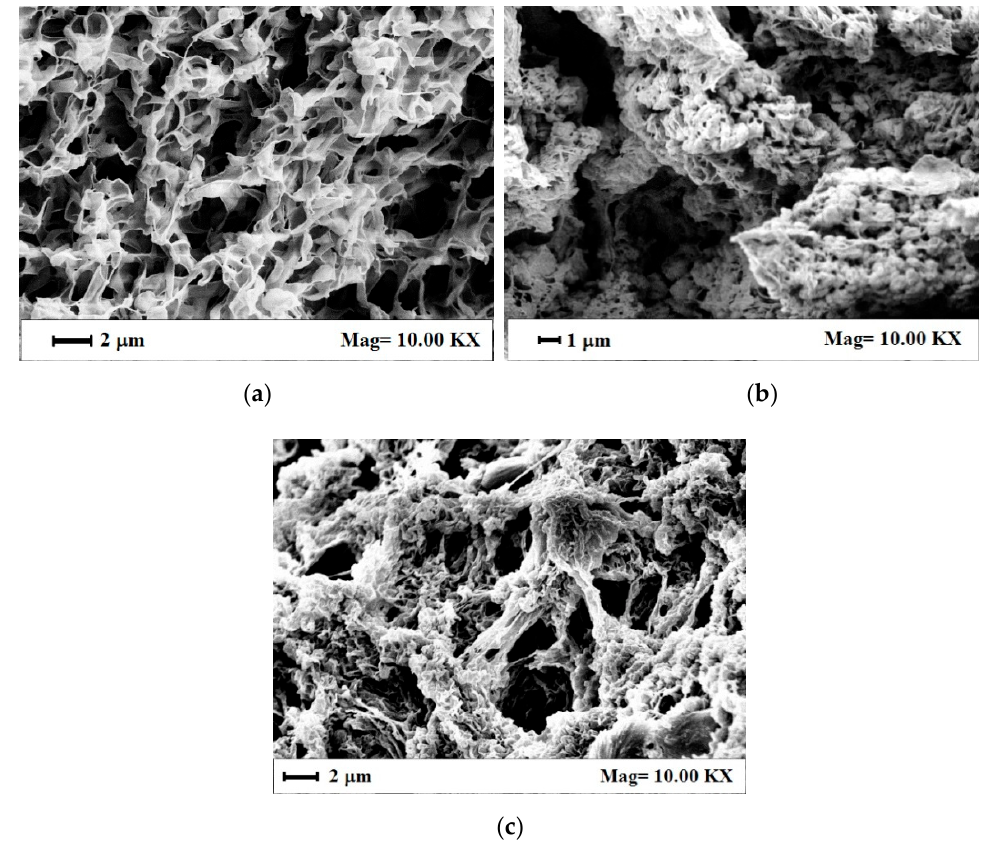
Figure 6. SEM images of the internal aerogel section: ( a ) PVDF HFP alone, ( b ) PVDF HFP_RuO 2 10, ( c ) PVDF HFP_RuO 2 60.